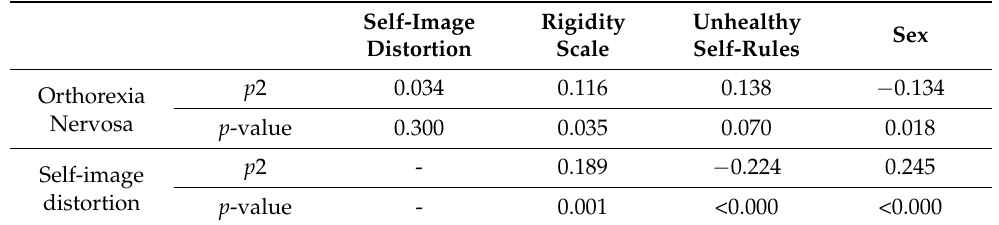
Table 3. Correlation between orthorexia nervosa, self-image distortion, behavioral rigidity, and unhealthy self-rules of students from a Brazilian Public